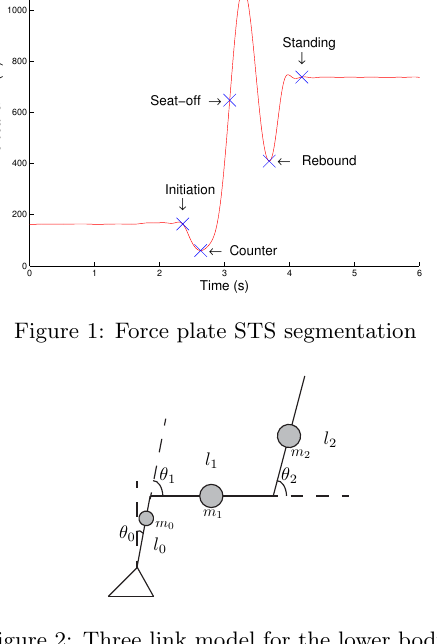
is followed by Seat-off which is when the subject’s buttocks leaves the seat. The Vertical Peak is when the subject ex- erts the maximum downward force, which is followed by the Rebound, when the subject is fully extended with upward velocity, and ends with Standing. In [2], the authors de- termine seat-off using a pressure sensor on the chair and determine standing visually. As we do not have the same setup as the in [2], to determine seat-off, we use the time at which the derivative of the GRF changes from positive to negative. We choose the events by hand to determine the ground truth for the STS